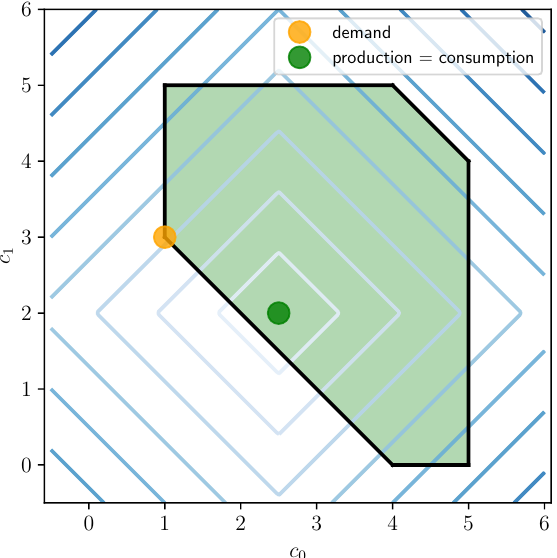
Figure 3. OPT in a simplified flexibility region (shaded region). The dark dot depicts the production signal to be tracked. The contour lines of the objective function are lines of constant L1-distance to the production signal. As the latter lies within the flexibility region, it coincides with the consumption returned by the OPT